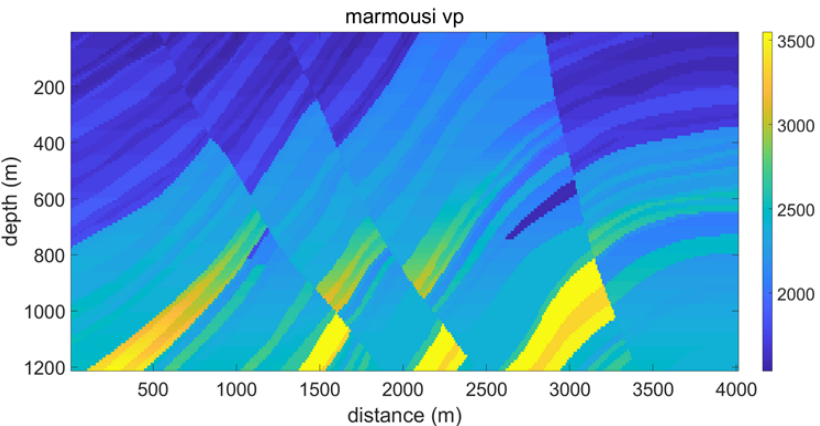
Figure 8. Marmousi model: acoustic velocity model.